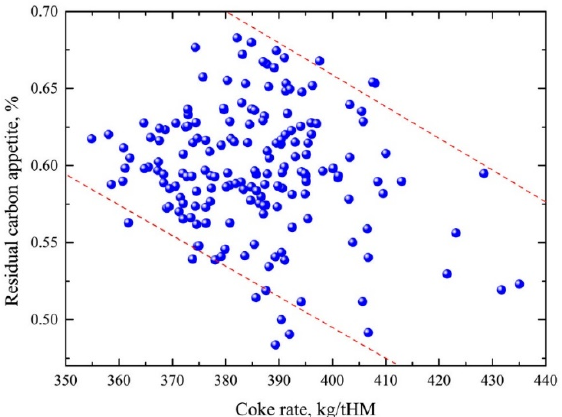
Figure 9. Comparisons between the coke rate and residual carbon appetite of tapped hot metal from the blast furnace.